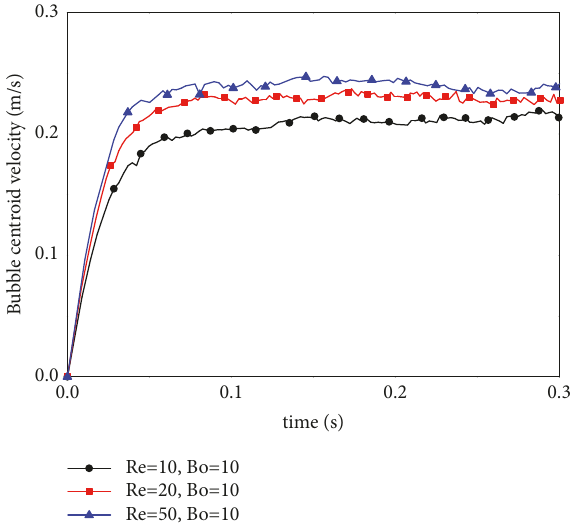
Figure 9: The change of bubble centroid rising velocity with time under static